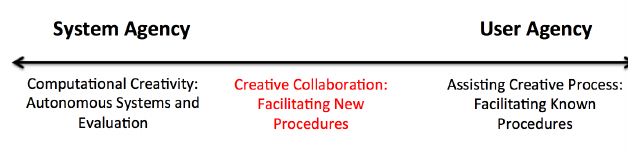
Figure 1. Current Creativity System Design from Autonomous Systems to